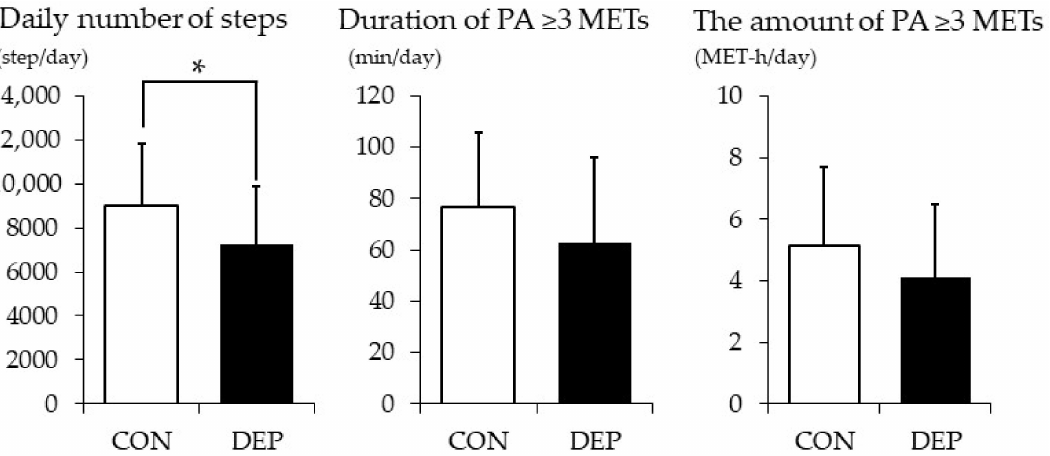
Figure 1. Daily number of steps, duration, and the amount of PA ≥ 3 METs. Values are presented as means ± SD. CON: control group; DEP: higher levels of depressive symptoms group, PA: physical activity, MET: metabolic equivalent. * p <